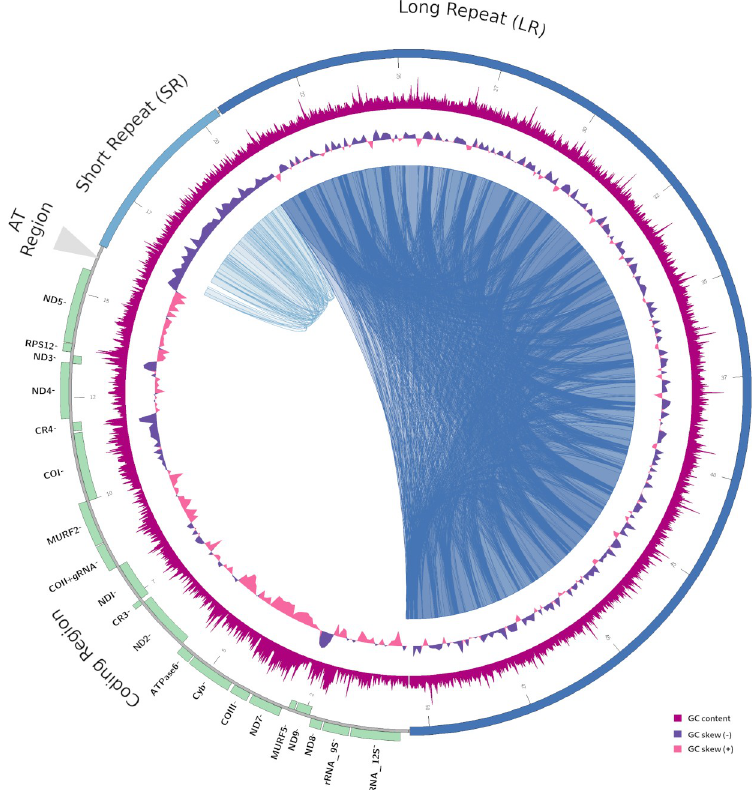
Fig 1. Architecture of T . cruzi maxicircle. Schematic representation of Tc Dm28c maxicircle. Repetitive regions are denoted by internal blast hits inside the circle (blue and light blue). The GC-skew (windows size 100 bp) are represented in violet (positive) and pink (negative). The GC content (window size 100 bp) is represented in magenta. The localization of all annotated genes are shown in the outer circle indicating their coding direction (outer + strand,